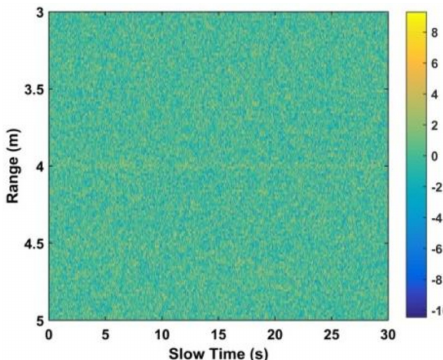
Figure 3. The resulting matrix with AWGN at an SNR of 0